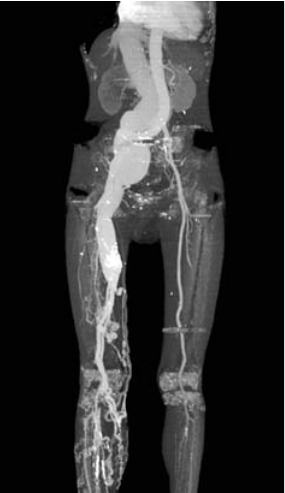
Figure 3: Computed tomographic angiogram of the patient shows an aneurysmal dilatation of the artery and vein proximal to the largest AVF in the midthigh. There were also multiple AVFs along the right leg from the external iliac artery to the distal superficial femoral artery.